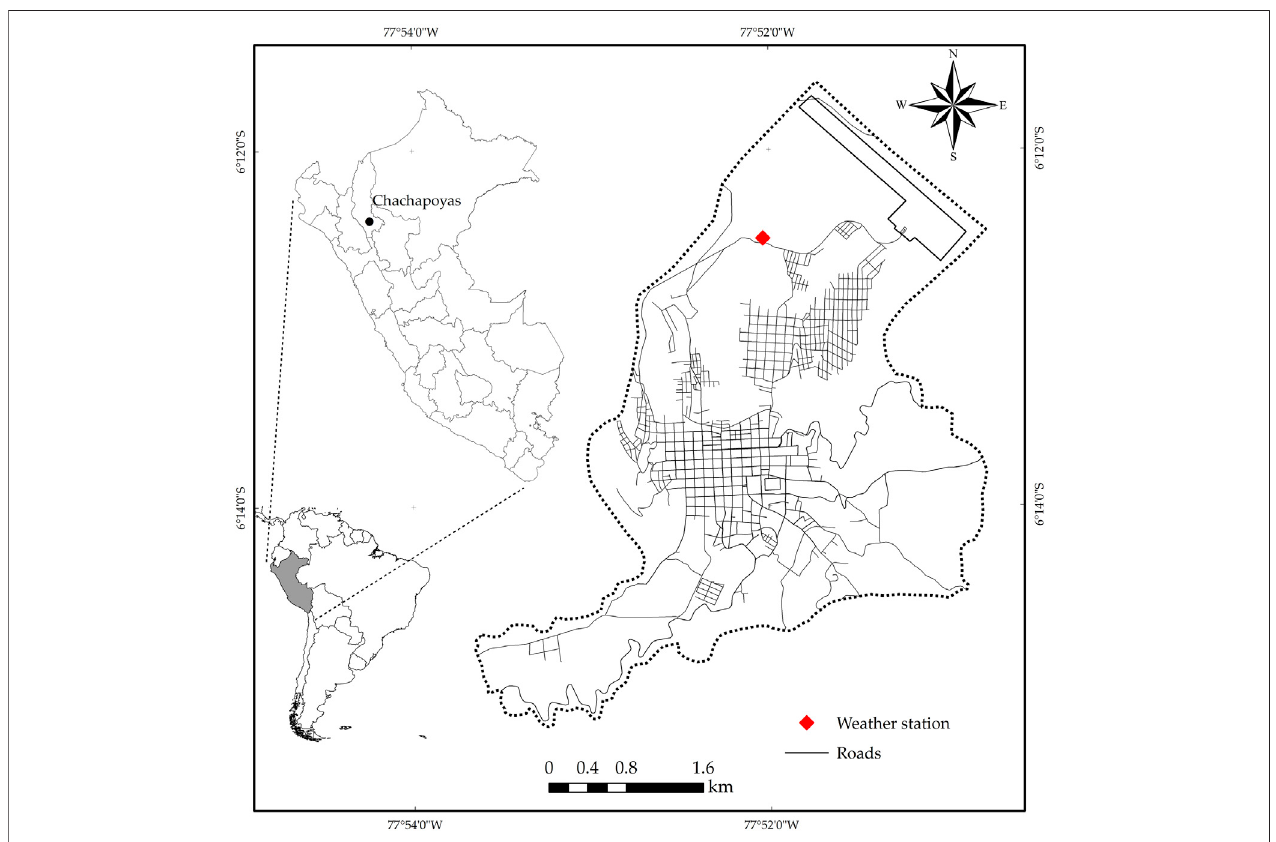
FIGURE 1 | Geographic localization of study